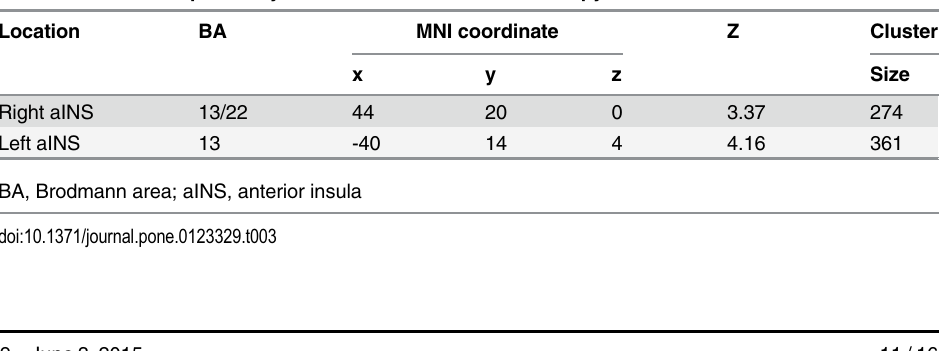
Table 3. Brain areas positively correlated with behavioral